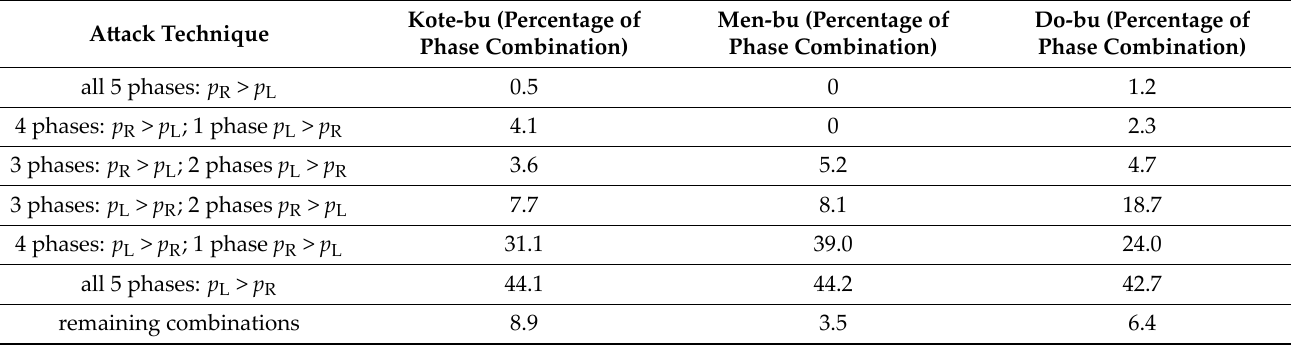
Table 2. Percentages of combinations of left and right grip pressures; p =